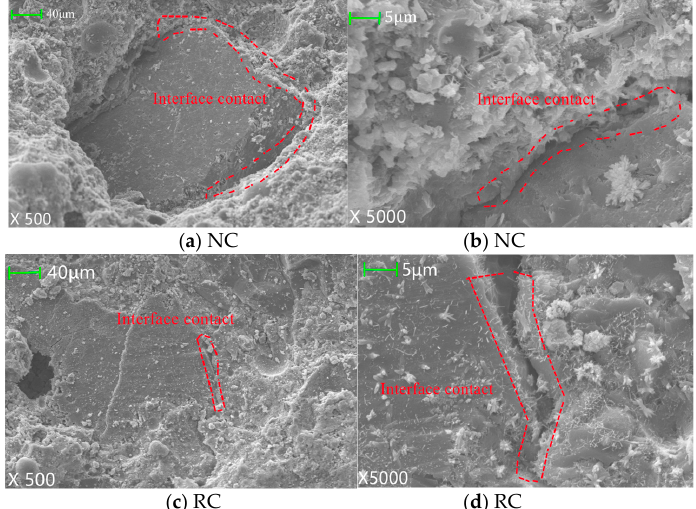
Figure 13. SEM image of NC and RC concrete.